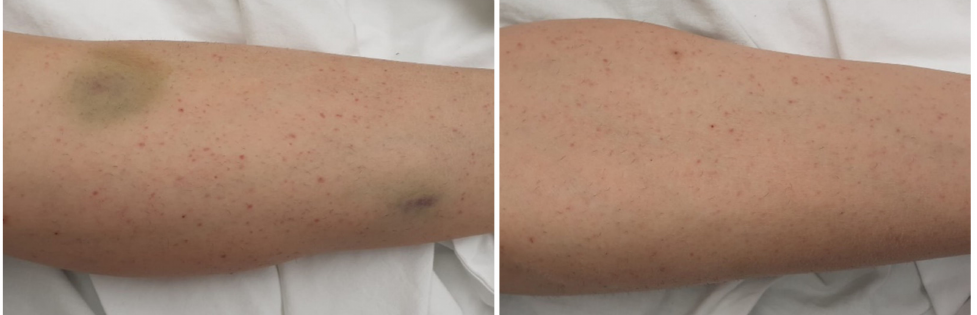
Figure 1. Ecchymosis and skin purpuric lesions of the lower